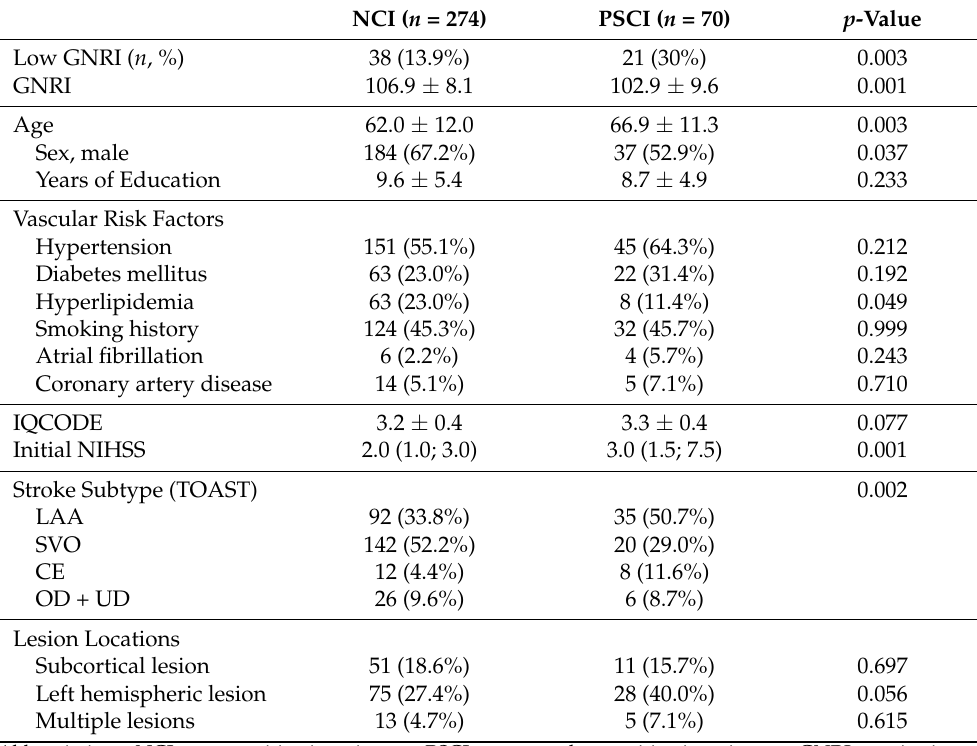
Table 1. Baseline characteristics according to the presence of post-stroke cognitive